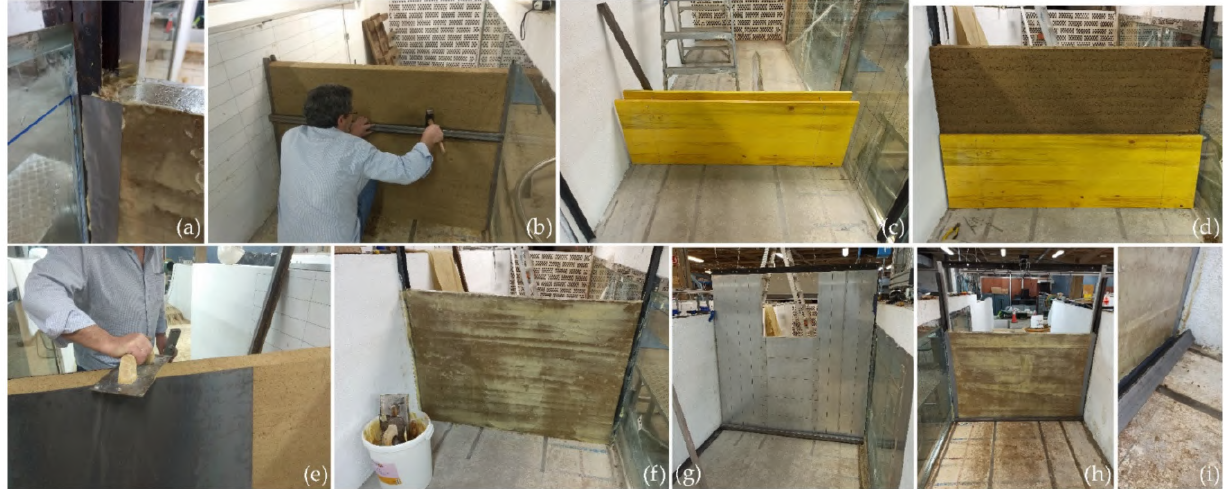
Figure 3. Images of the construction of the cohesive central core: ( a ) Placement of tape on the ‘vertical’ joints between the cohesive core and the metallic L profiles to avoid seepage; ( b ) Cut excess material from the core downstream face; ( c ) Formwork to compact the cohesive material; ( d ) Removal of the two upper panels of the formwork after compaction is finished; ( e ) Cut excess material from the core crest; ( f ) Protection of the downstream face and crest of the core with industrial vaseline (B-2 from Tecmasol); ( g ) Placement of downstream protection to simulate the downstream shoulder support; ( h ) Protection of the upstream face of the core with industrial vaseline (B-2 from Tecmasol); ( i ) Placement of tape on the horizontal joint between the cohesive core and the floor and placement of a metallic profile to avoid lifting and buoyancy of the